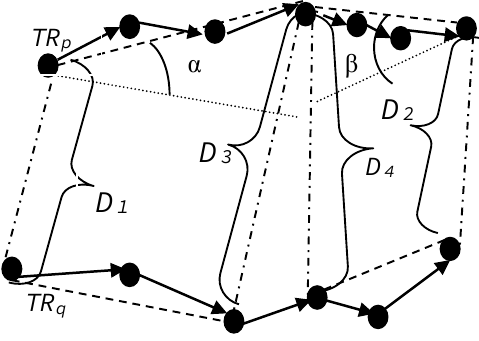
Figure 5. Distance metric for two trajectories with similar start-end